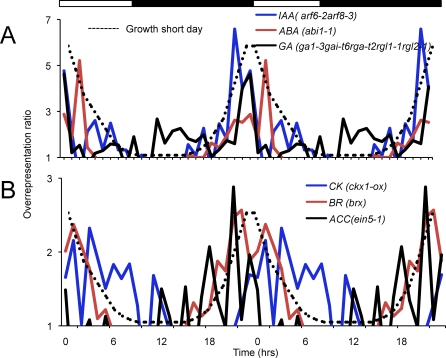
Misregulated Genes in Selected Phytohormone Mutants Are Expressed at Dawn under Short-Day Photocycles(A) The genes that are differentially expressed in the arf6-2arf8-3, abi1-1, and DELLApenta (ga1-3 gai-t6 rga-t2 rgl1-1 rgl2-1) mutants are overrepresented around dawn under short-day photocycles.(B) The genes that are differentially expressed in the ckx1-ox, brx, and ein5-1 mutants are overrepresented around dawn under short-day photocycles.Mutant microarray data from published sources and differentially expressed genes (p < 0.01) were identified by comparing mutant expression to the wild-type expression (Materials and Methods). Z-score profile is double plotted for visualization purposes, and the dotted line is the growth rate under short-day photocycles. Hypocotyl growth rate under short-day photocycles (black dotted line) is reproduced to provide a frame of reference for time of day of maximal hypocotyl growth.